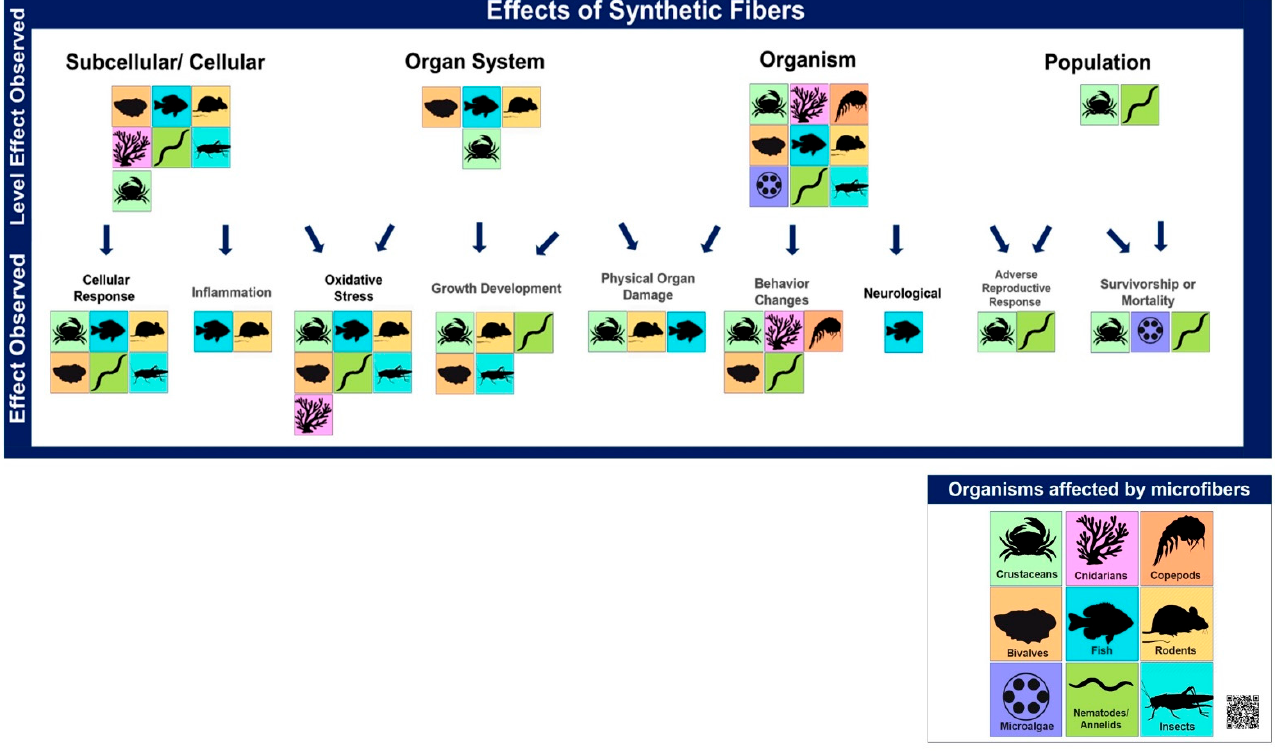
Figure 2. The effects of synthetic fibers on organism health have been documented across biological levels in a diverse array of species. Slanted arrows show an effect on more than one level. From Granek et al., 2022. Table 1. Ecological and biological effects of fibers on organisms by species and material type. Mod- ified from Granek et al. 2022.